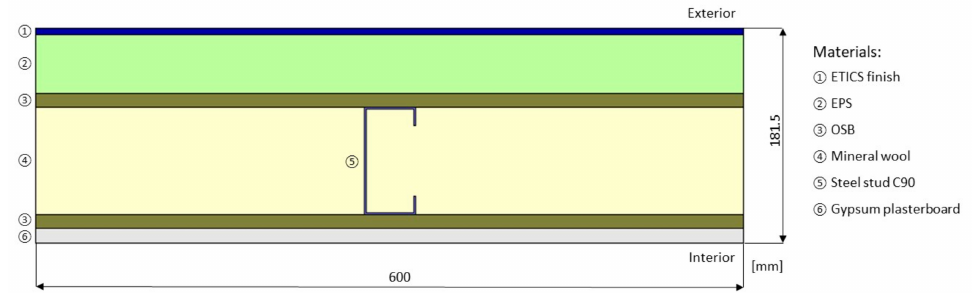
Figure 4. Cross-section of an exterior LSF reference wall modeled on THERM